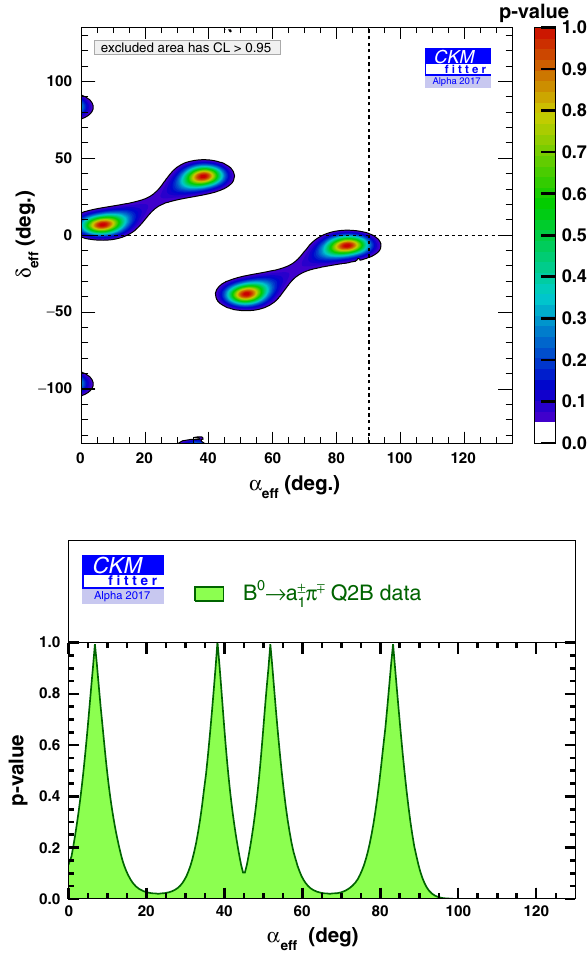
Fig. 51 Two-dimensional constraint in the ( α eff , δ eff ) plane from the π ∓ decay ( top ) and one-dimensional Q2B analysis of the B 0 → a ± 1 projection for α eff ( bottom